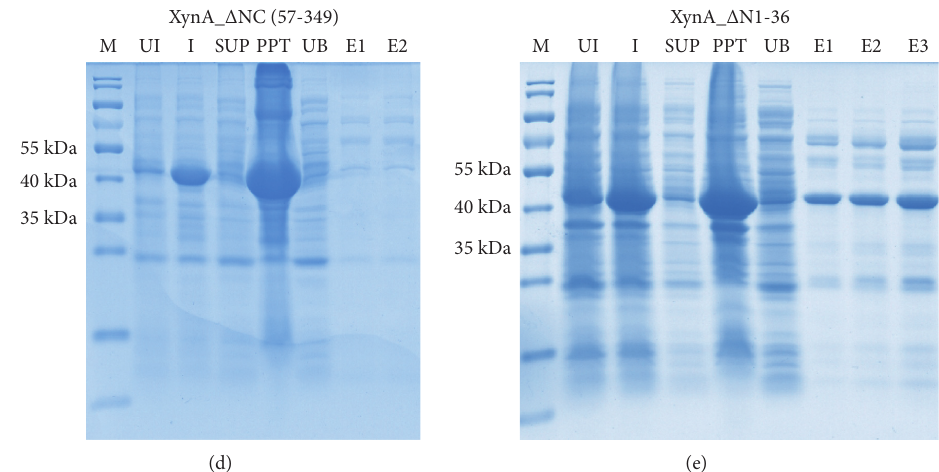
Figure 3: Enzyme engineering and protein expression. (a) Schematic domain of XynA, with boundaries indicated. The N-terminal domain, GH10 domain, and C-terminal domain are coloured purple, cyan, and pale green, respectively. Below are some truncations designed to improve the enzyme activity: XynA_ Δ C (39.28 kDa) represents the removal of the C-terminal domain; XynA_ Δ N (40.70 kDa) represents the removal of the N-terminal domain; XynA_ Δ N1-36 (44.32 kDa) represents the removal of residues 1–36 at the N-terminal domain; and XynA_ Δ NC57-349 (35.40 kDa) represents the removal of residues 1–56 at the N-terminus and residues 350–408 at the C-terminal domain. (b)–(e) 12% SDS-PAGE analyses of XynA’s expression. M, marker; UI, uninitiated; I, initiation; SUP, supernatant; PPT, precipitation; UB, unbound protein; W, wash protein; and E,